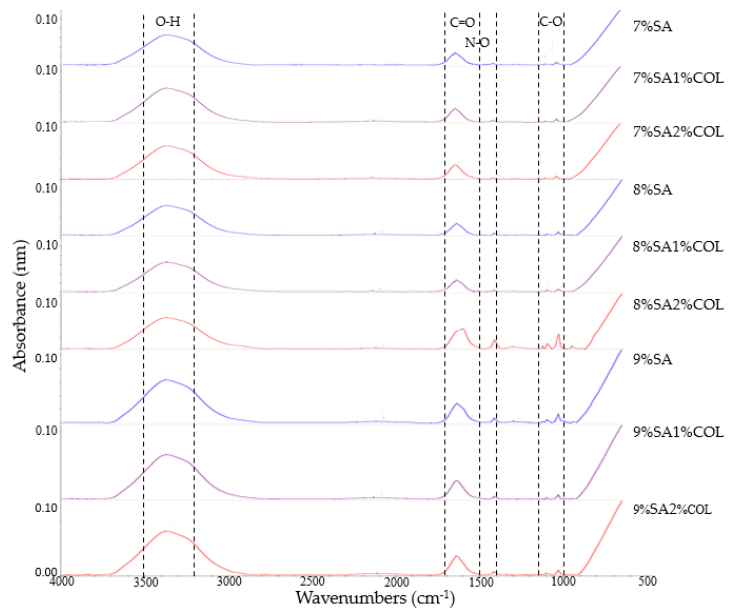
Figure 5. FT-IR for SA/COL solutions.